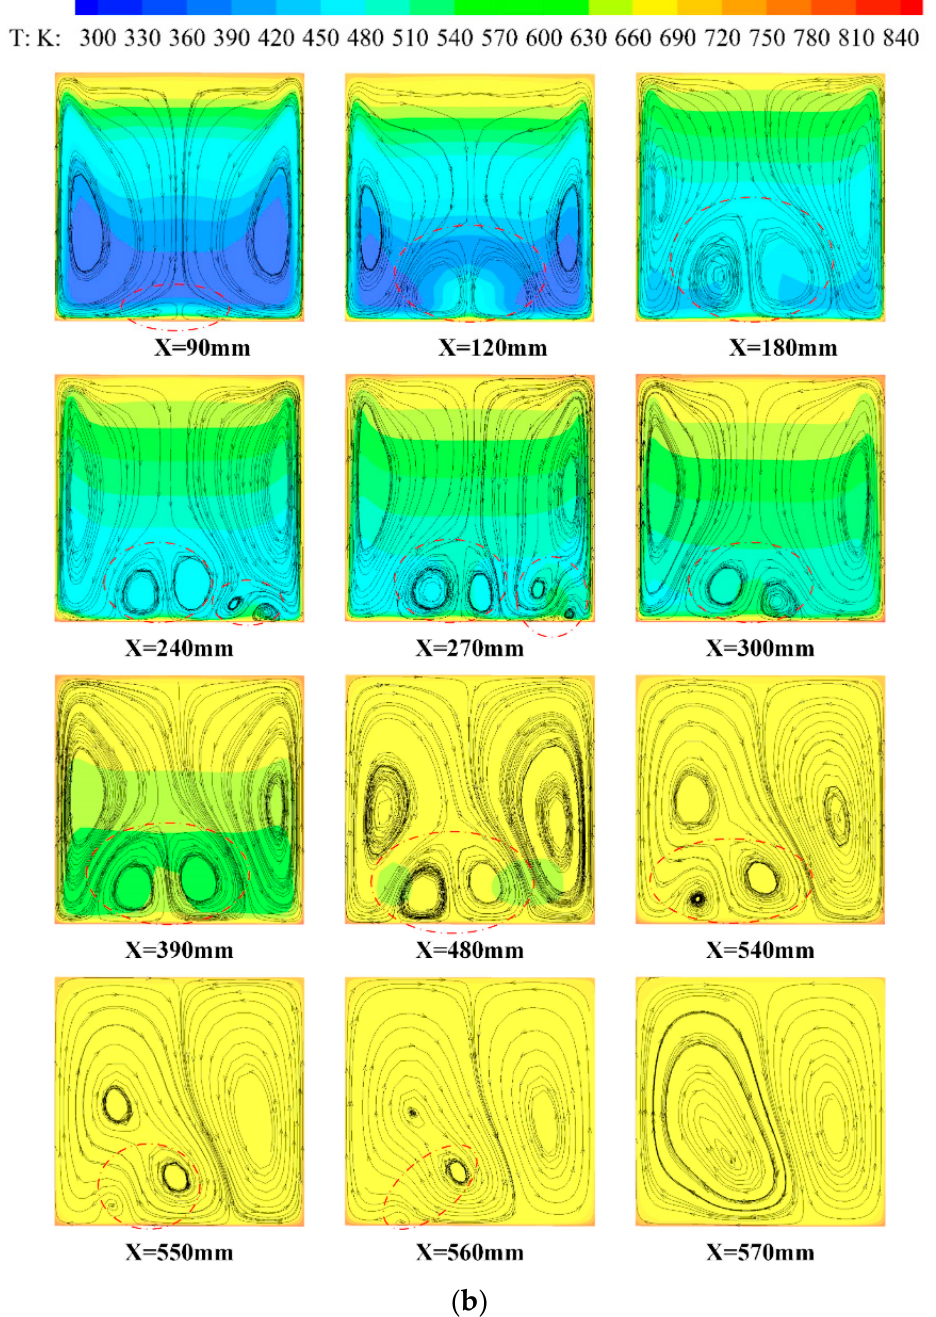
Figure 12. Streamline diagram of the cross section at different positions with the heat flux of: ( a ) 0.4 MW/m 2 ; ( b ) 0.5 MW/m 2 .